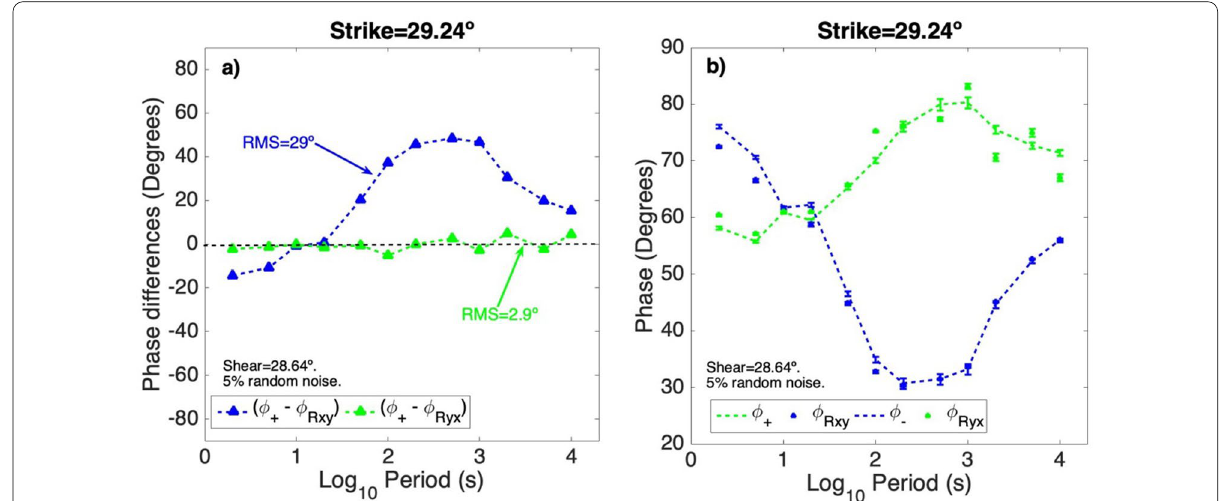
Fig. 9 a Differences of the phases of Z Rxy and Z Ryx and ∅ the phase of Z Ryx . Notice the larger scattering of the phases of Z Ryx as compared with the values of ∅